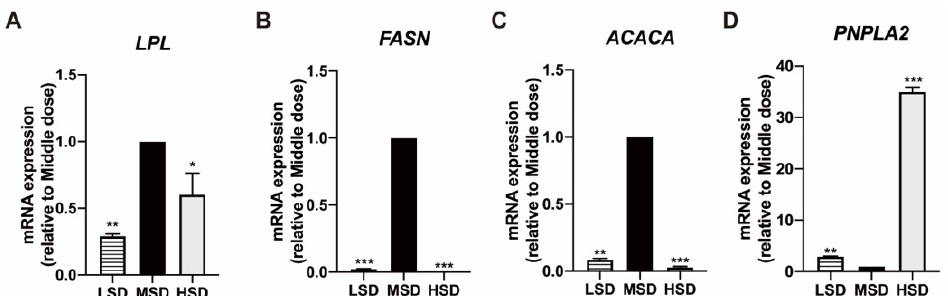
Figure 6. Effect of feeding density on fat metabolism in Kunming mice. ( A ) qPCR analysis was performed to assess the mRNA abundance of LPL in mice of different feeding density. ( B ) qPCR analysis was performed to assess the mRNA abundance of FASN in Kunming mice of different feeding density. ( C ) qPCR analysis was performed to assess the mRNA abundance of ACACA in mice of different feeding density. ( D ) qPCR analysis was performed to assess the mRNA abundance of PNPLA2 in mice of different feeding density. Data were presented as a mean ± SD, n = 3, * p < 0.05, ** p < 0.01, *** p < 0.001, vs. MSD group.